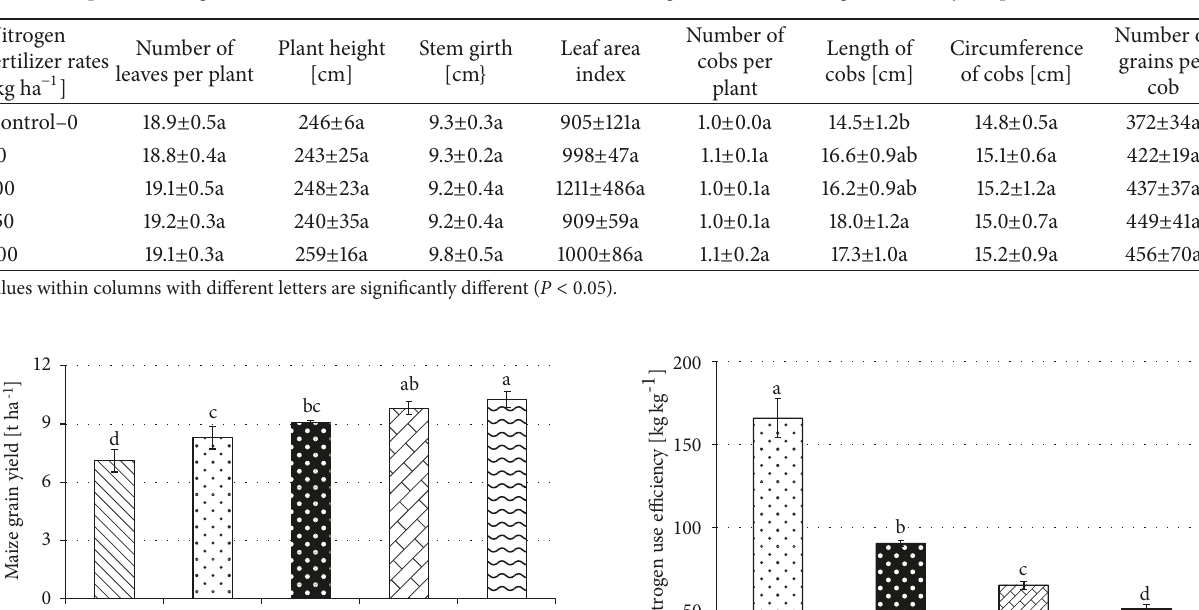
Table 2: Impact of nitrogen fertilizer rates (control–0, 50, 100, 150, and 200 kg ha −1 ) on maize vegetative and yield parameters (Mean ± SD).